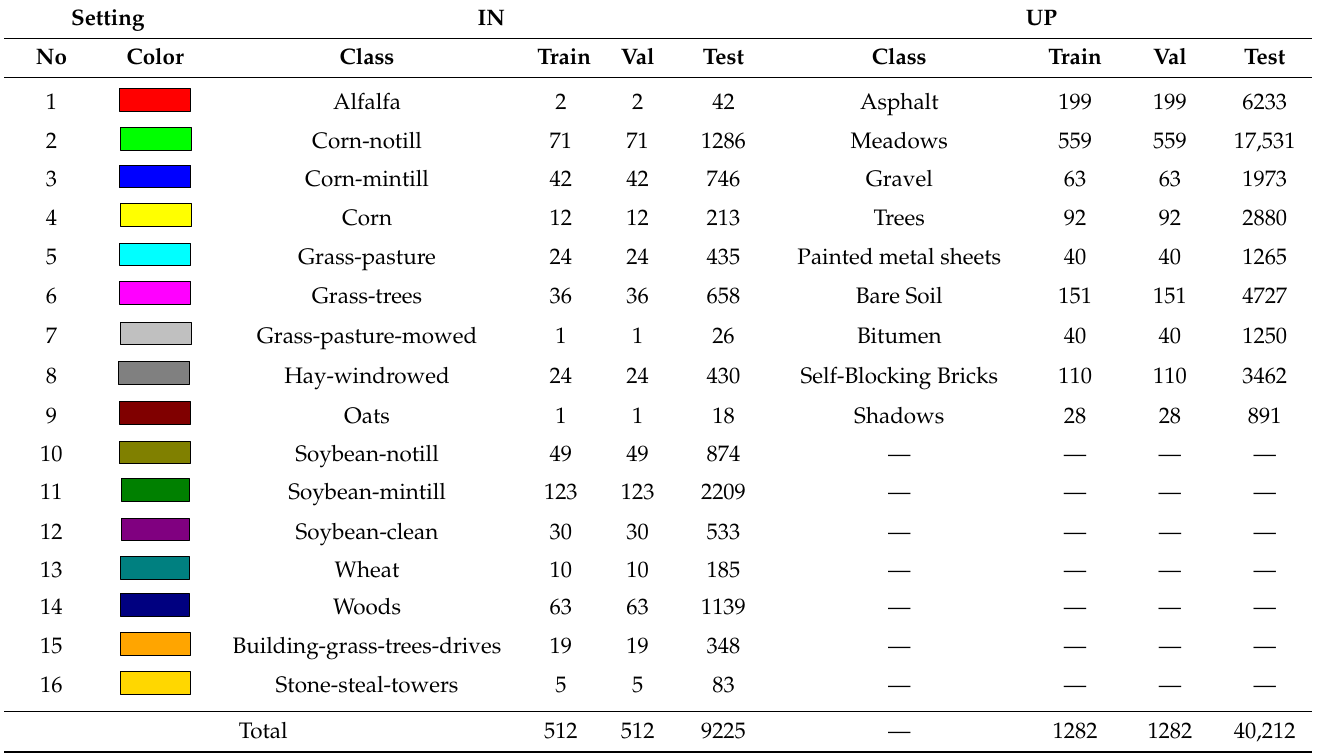
Table 1. Land cover category and number of samples for training, validation, and testing of IN and UP.